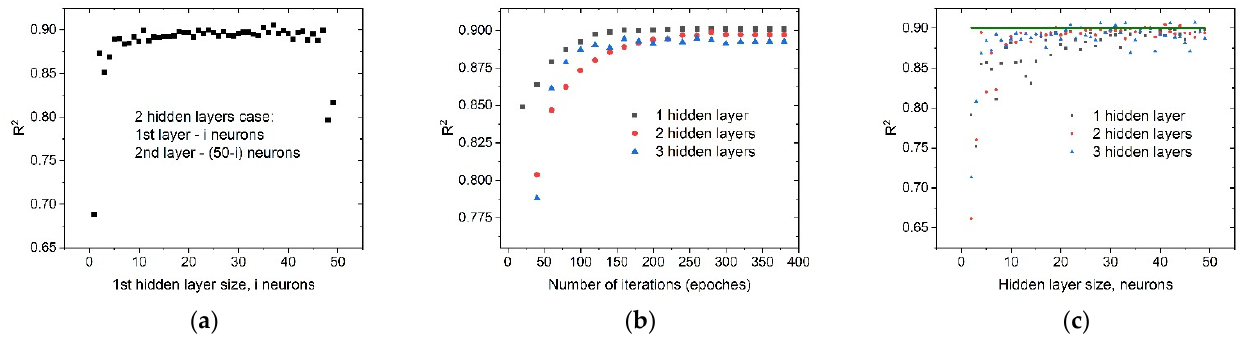
Figure 6. Determining the optimal architecture: ( a ) R 2 as a function of distribution of 50 neurons over layers in the two-layer network; ( b ) R 2 as a function of the number of iterations for the single-layer, two-layer, and three-layer ANN architecture with the optimal number of neurons; ( c ) R 2 as a function of the number of neurons per layer for the single-layer, two-layer, and three-layer ANN architecture. Green line indicates level R 2 = 0.9.